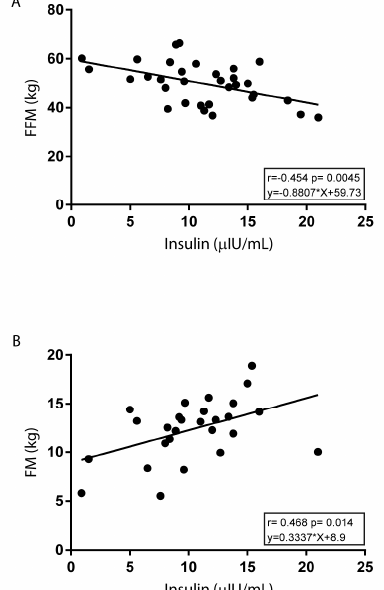
Figure 3. Correlations between insulin and FFM (kg) or FM (kg) in Group C. Association of insulin with FFM (kg) ( A ) or FM (kg) ( B ) were analyzed by Pearson’s correlation test. For each linear regression graph, the linear equation (y), the correlation coefficient ( r ), and the statistical significance (p) are reported. Interestingly, assessing the correlation of irisin with metabolic parameters, we found a negative association between irisin and both total cholesterol ( r = − 0.428 and p = 0.04) and LDL ( r = − 0.468 and p = 0.02) in Group C (Figure 4). Nutrients 2020 , 12 , x FOR PEER REVIEW